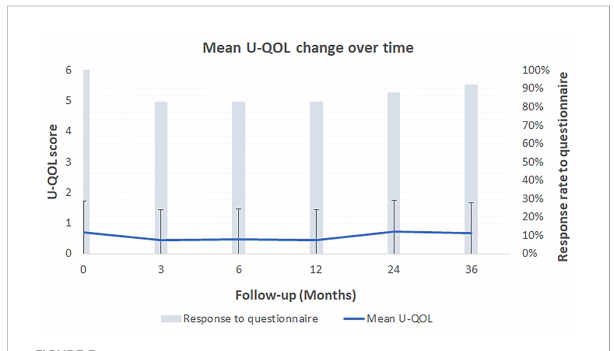
FIGURE 3 Patient-reported outcome: Mean U-QOL score change over time along with the standard deviation from the mean score.